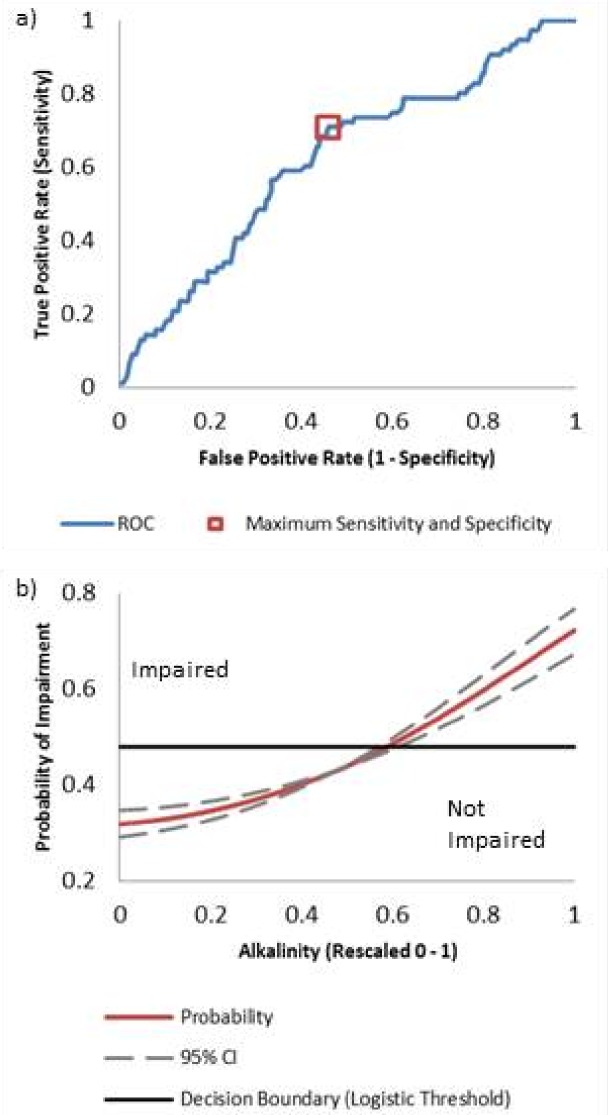
Theoretical plots to illustrate the concept of the ROC, decision boundaries, and action values.(A) Plot of an ROC curve, where the x-axis represents the false positive rate, or the compliment of the specificity, and the y-axis represents the true positive rate, the sensitivity. The curve is integrated to obtain the AUC, the performance metric for each of the models. The box represents the point at the decision boundary (B) Theoretical plot of a univariate Maxent model function (Eq. (3)) with values for alkalinity rescaled from 0 to 1. The solid red line represents Eq. (3), the dotted lines represent the upper and lower 95% confidence intervals, and the horizontal black line represents the decision boundary. The action values, or environmental thresholds, and associated confidence intervals are the intersections between the results of Eq. (3) and the decision boundary.